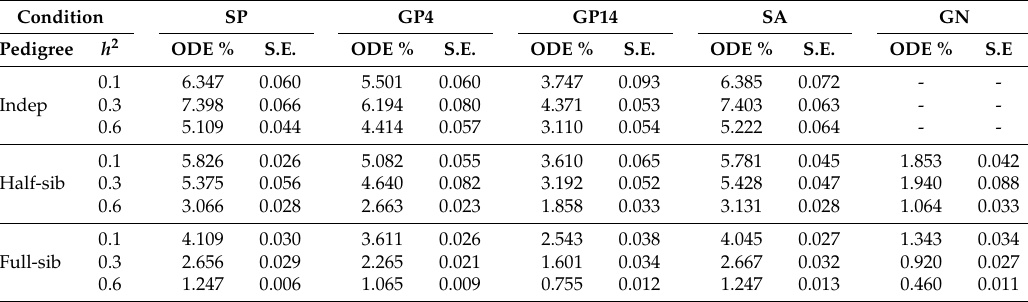
Table 2. Average ODEs from 10 replicates per condition are reported together with standard errors (S.E.) for simple pairwise (SP), greedy pairwise (GP4 and GP14), simulated annealing (SA) and genetic ( 30 ) neighborhood (GN) procedures for Ω RCB designs at a spatial correlation of A